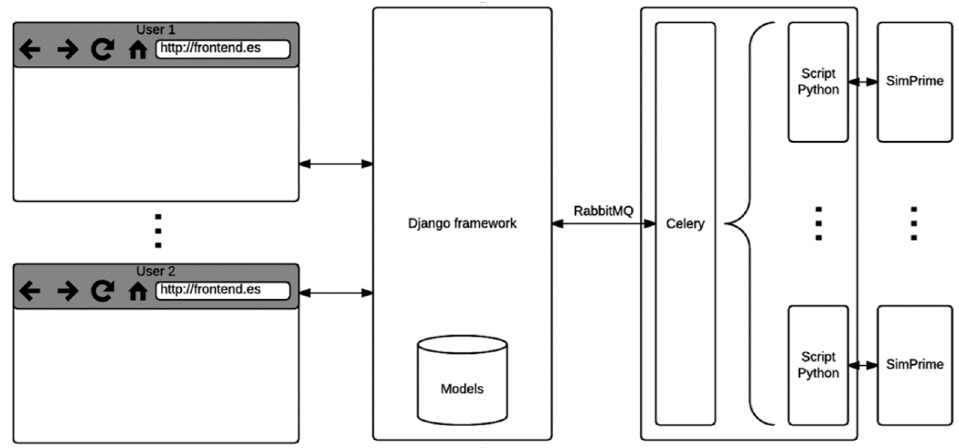
Figure 1. Architecture and technologies used in the web application developed for